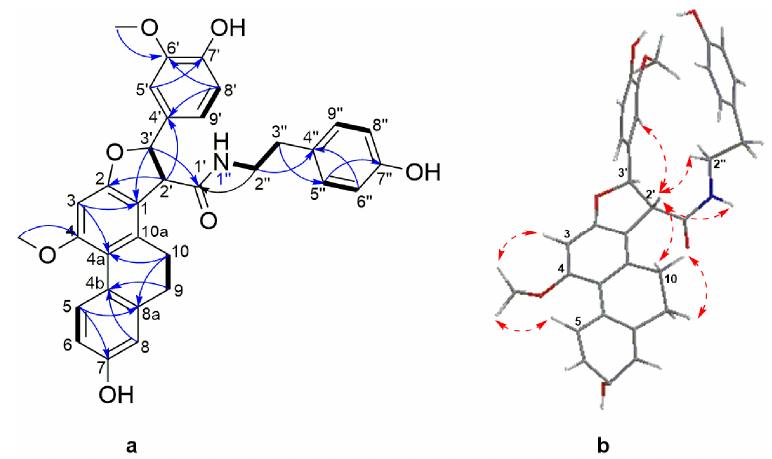
Figure 4. ( a ) Selected COSY (plain bonds) and HMBC (blue arrows) correlations of 6 ( b ) Energy minimized 3D structure and selected NOESY correlations (red dashed arrows) of 6 . Table 3. 1 H (500 MHz), 13 C (125 MHz), HMBC and NOESY spectroscopic data of compound 6 ( δ in ppm, J in Hz) in acetone- d 6 .